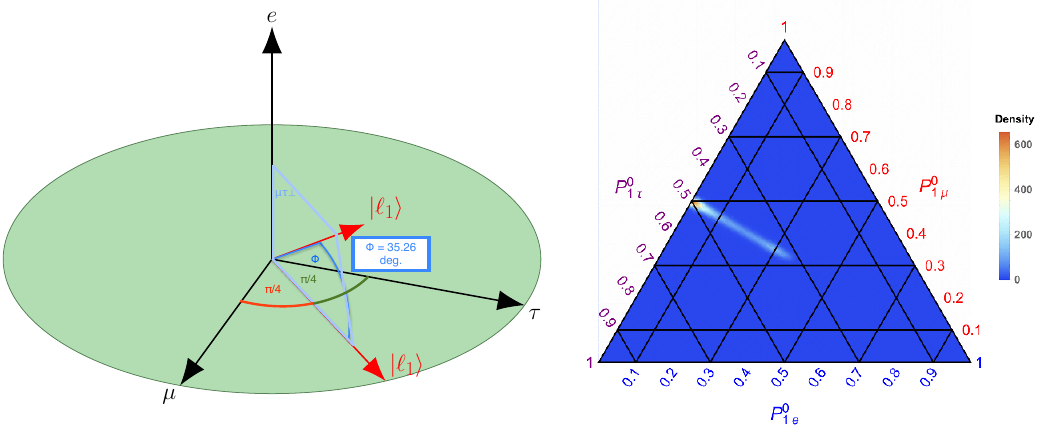
Figure 14 . Left: possible range of the orientation of the state with hierarchical light neutrinos. Right: in the same model, ternary plot for the probabilities P 1 (cid:11) = K 1 (cid:11) = P K 1 (cid:11) with corresponding (cid:11)